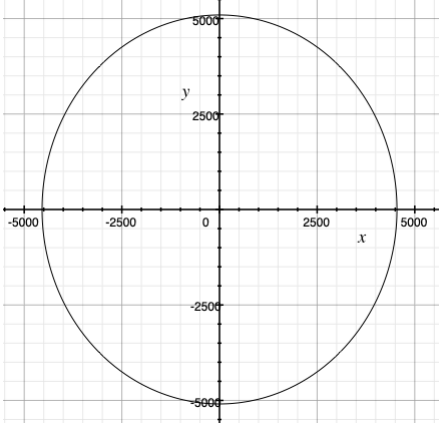
Figure 12. Outline of the model behavior in 2